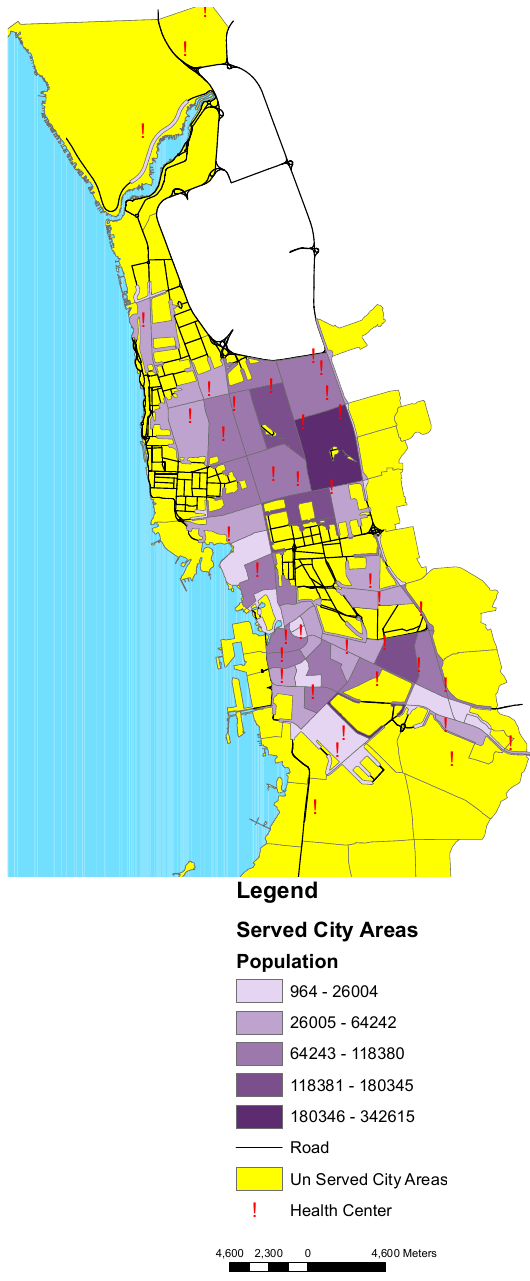
Figure 4. Population served by health centers.